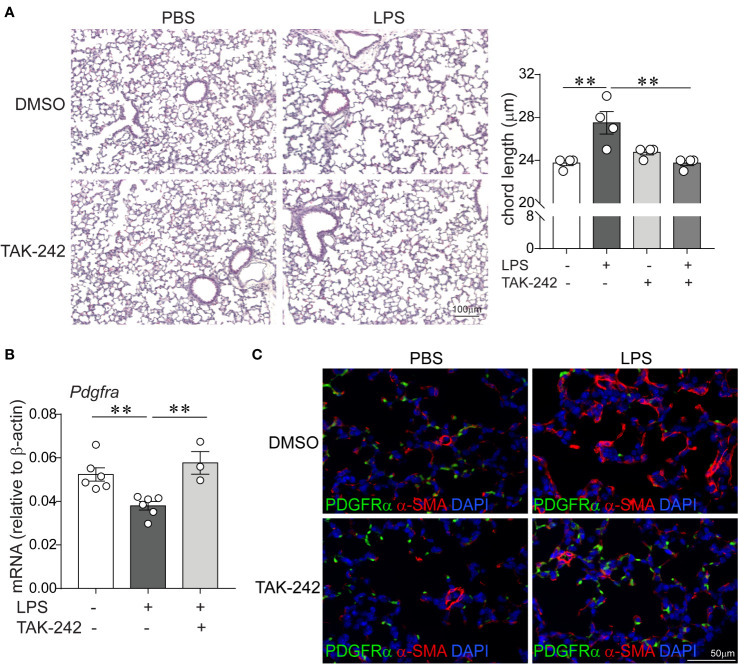
Pharmacological inhibition of TLR4 with TAK-242 attenuates the effects of chronic LPS exposure on alveolarization, α-smooth muscle actin and PDGFR-α expression in the distal lung. Immature wild type mice were inoculated intranasally with LPS or PBS and treated intraperitoneally with control (DMSO) or the TLR4 inhibitor TAK-242 on days of life 3, 5, 7, and 10. Lung histology was assessed on day of life 14. (A) Representative lung sections were stained with hematoxylin and eosin. Unlike control (DMSO)-treated mice, LPS-exposed TAK-242-treated mice do not develop increased alveolar size indicative of hypoalveolarization. After LPS exposure, the chord lengths of TAK-242-treated mice were significantly lower compared to control (DMSO)-treated mice. N = 3–4 per group, mean ± SEM, **different from PBS-exposed group, **P < 0.01. (B) Whole lung PDGFR-α mRNA expression was decreased after repetitive LPS exposed in control (DMSO)-treated, but not in TAK-242-treated mice. N = 3–6 per group, mean ± SEM, **different from PBS-exposed group, **P < 0.01. (C) Fluorescence microscopy shows after LPS exposure there is increased deposition of α-smooth muscle actin (red) in the alveolar interstitium and reeduced PDGFR-α expression (green) at the tips of secondary crests in control (DMSO)-treated mice, but not in TAK-242-treated mice. The representative images are from a random coronal section. The experiments were repeated two times with similar results.